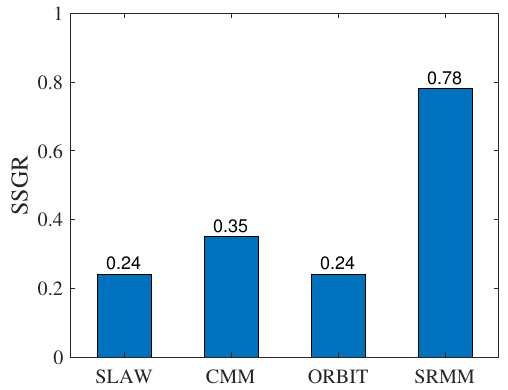
Figure 7. The same social group ratio values from various models with the synthetic